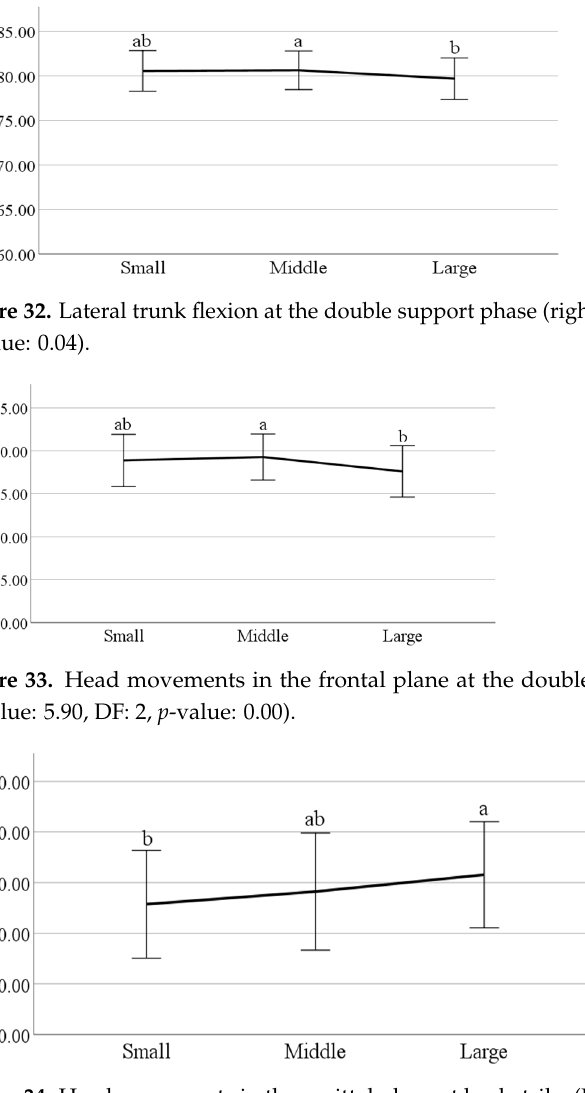
Figure 35. Mean head movements in the sagittal plane at heel-strike (F value: 3.21, DF: 2, p -value: 0.04). Table 10. Toe-in gait/toe-out gait (X² = 18.91, df = 4, p -value = 0.00) . Toe-In Gait